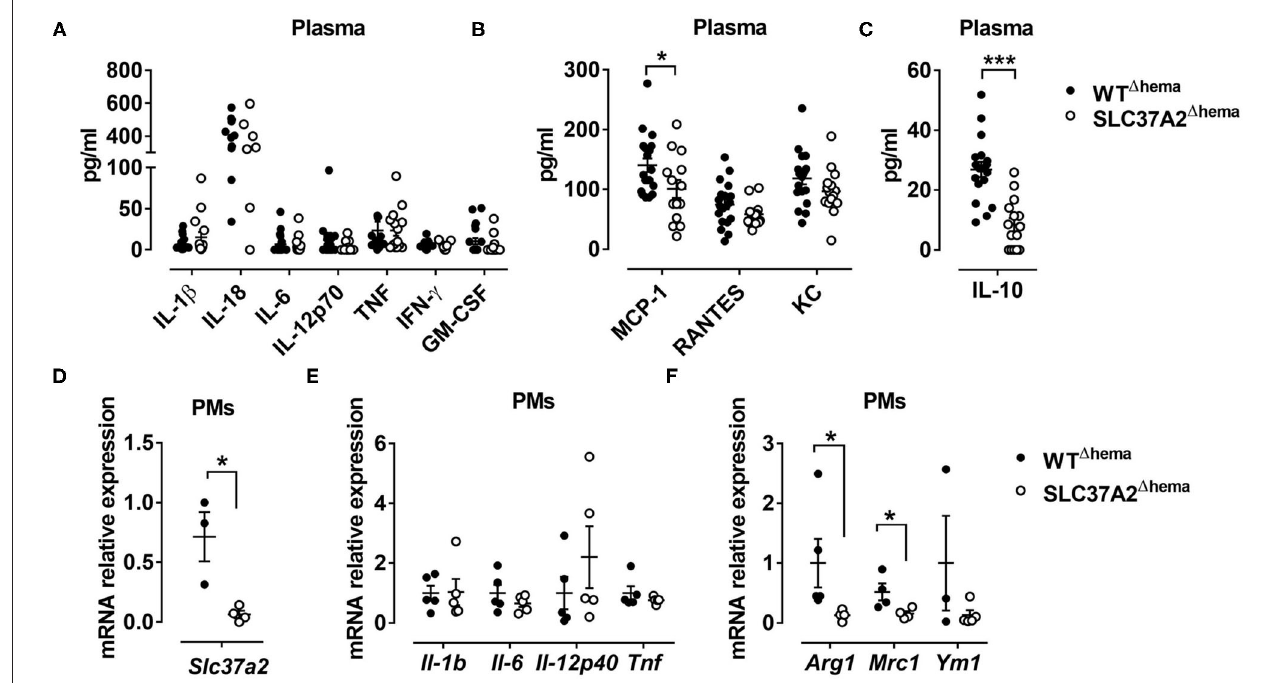
FIGURE 3 | Hematopoietic cell-specific SLC37A2 deletion primarily impairs anti-inflammatory responses in WD-fed Ldlr − / − mice. Hematopoietic SLC37A2 knockout (SLC37A2 1 hema ) and control (WT 1 hema ) Ldlr − / − mice were fed a high-fat western diet for 16 wks. (A–C) Plasma pro-inflammatory cytokine (A) , chemokine (B) , and anti-inflammatory cytokine IL-10 (C) concentrations were quantified by multiplex assay. (D–F) Relative transcript levels of Slc37a2, pro- and anti-inflammatory markers in resident peritoneal macrophages. Each symbol represents an individual mouse. Data are expressed as mean ± SEM. * p < 0.05; *** p < 0.001, unpaired, two-tailed Student’s t